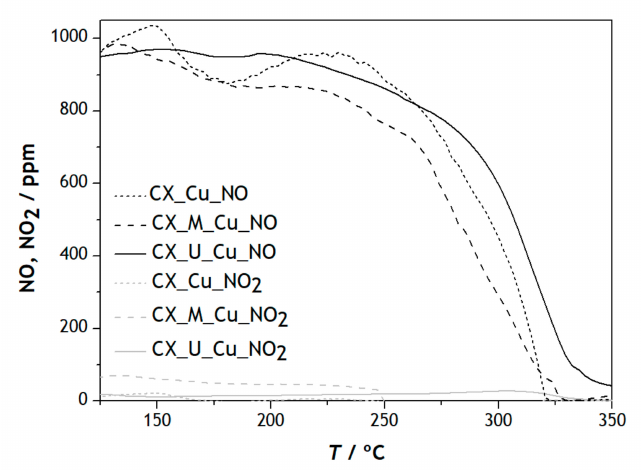
Figure A4. NO concentration in sample MF_U_10Cu with [NO] = 1000 ppm in He with 5, 10 and 20% of O 2